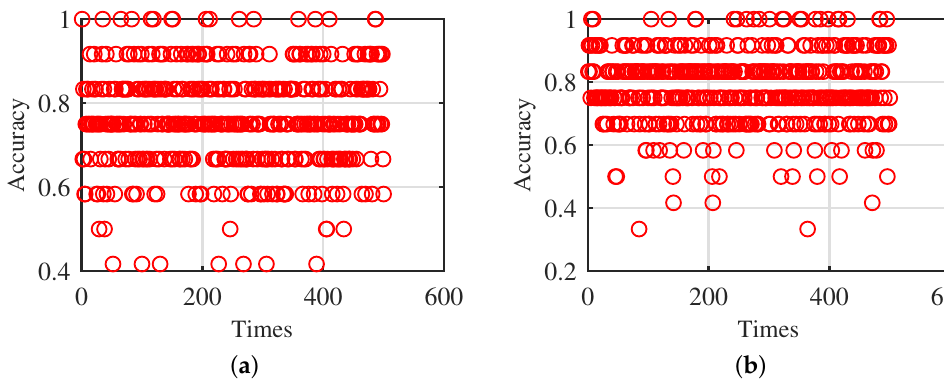
Figure 11. ELM for ( a ) and FFELM for ( b ).